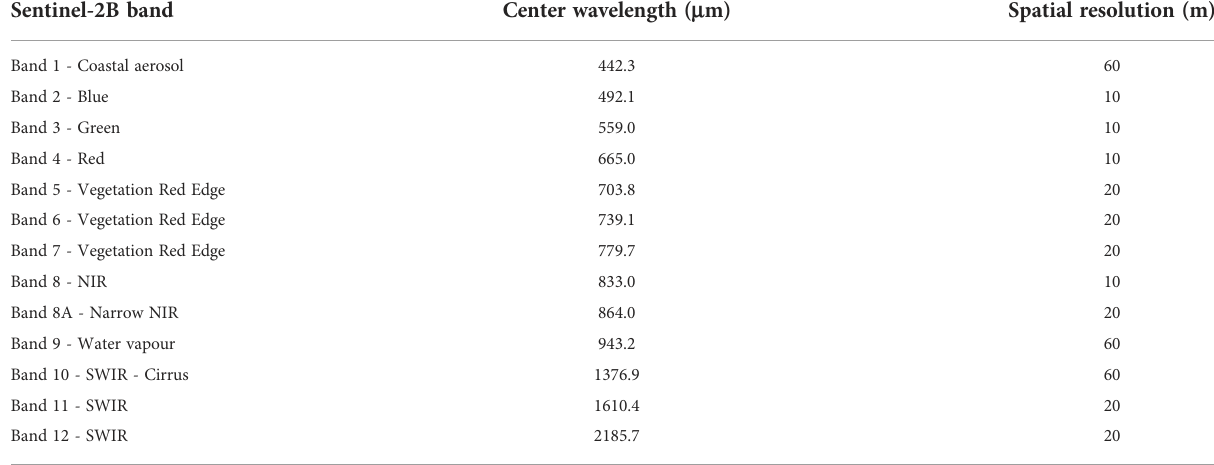
TABLE 2 Spectral characteristics of Sentinel-2B from the European Space